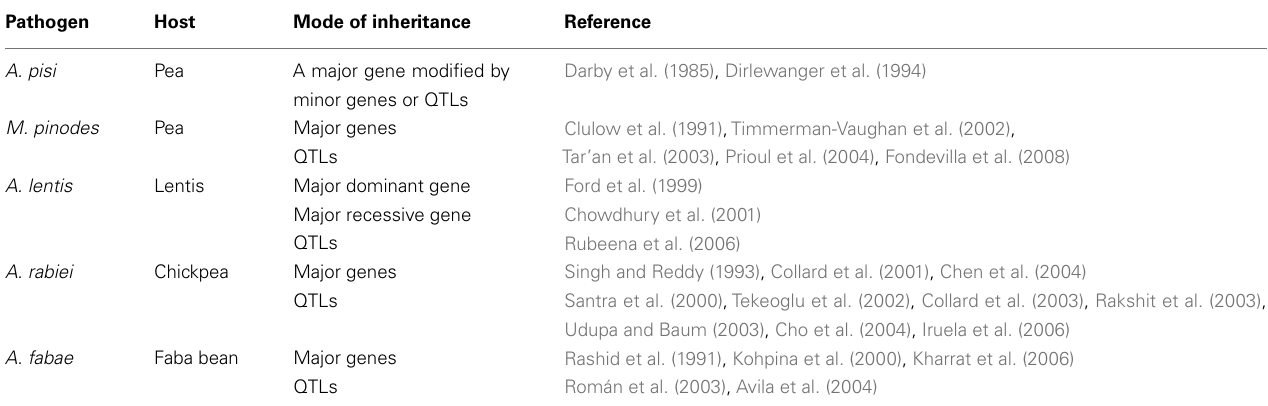
Table 1 | Mode of inheritance of resistance to ascochyta blight in